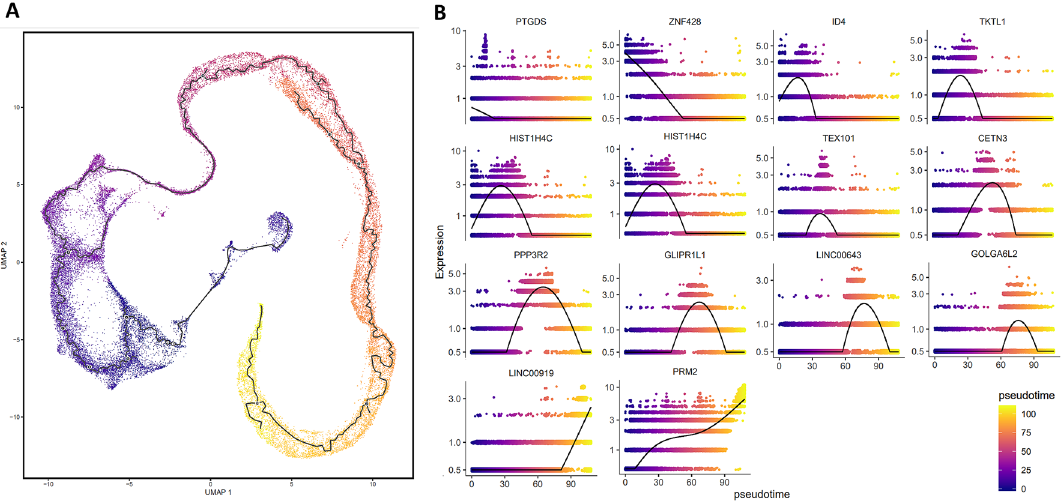
Figure 3. Developmental ordering of spermatogenesis cells. ( A ) The pseudotime analysis of testicular cells on the UMAP space, purple cells represent the beginning of the path and yellow cells represent the end of the path ( B ) the expression of top positive DEGs in each cluster along the